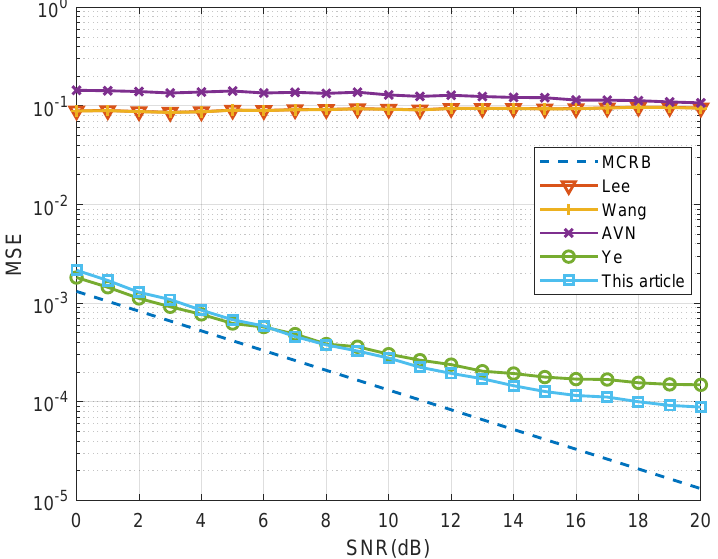
Figure 6. Timing error estimation algorithm used on